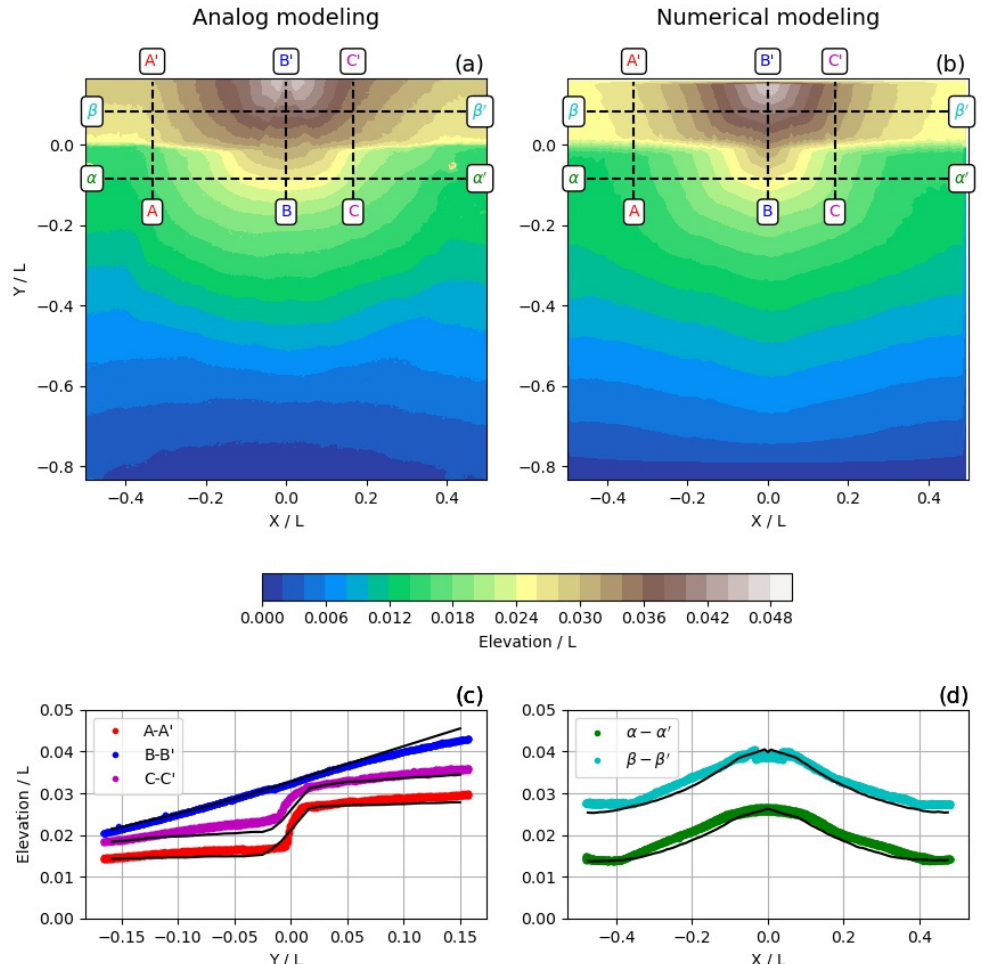
Figure 7. Final topography obtained from both experimental and numerical approaches. ( a ) Experimental modeling result. Color scale gives the normalized elevation associated with a fan building stage of 1.5 h followed by a 1h fault activity at a slip rate of 1 cm/h. Dashed lines show the location of profiles plotted in Figure 6c,d. ( b ) Same as ( a ) for numerical modeling with κ river = 10 − 4 , v s = 1 m.yr − 1 , κ hill ∈ 5 × 10 − 7 ;2 × 10 − 3 m.yr − 1 , and n = 2, assuming a fan building stage of 54 ka and a fault slip rate of 2.8 mm.yr-1 during 36 ka. ( c ) and ( d ) show swath profiles obtained from experimental (color circles) and numerical (black lines) approaches.